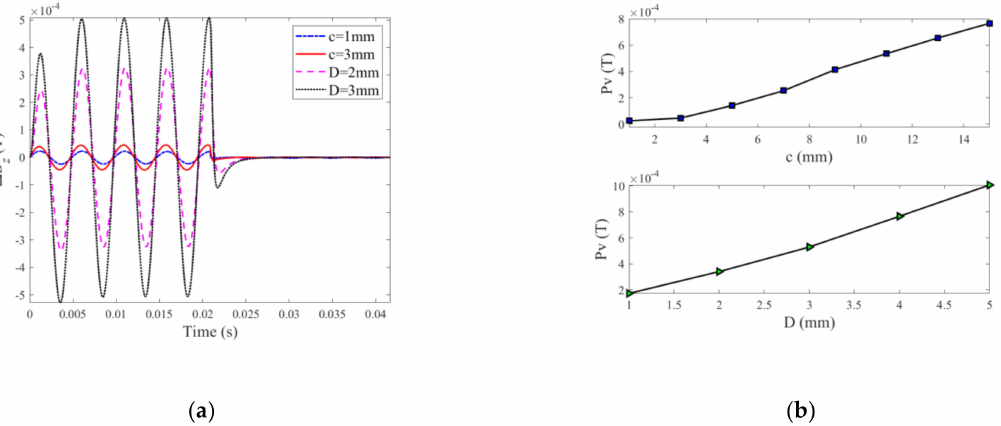
Figure 5. Difference signal and correlations of Pv: ( a ) difference signals with various radii and depths of ILC; ( b ) correlations of Pv with the radius and depth of ILC.